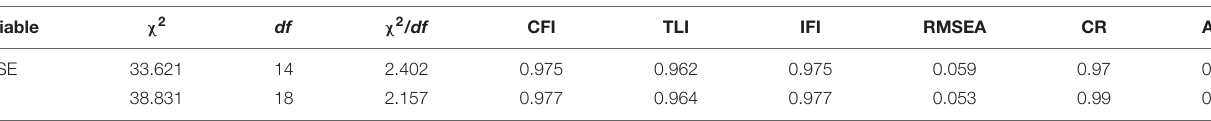
TABLE 3 | Confirmatory factor analysis of RBSE and voice behavior.